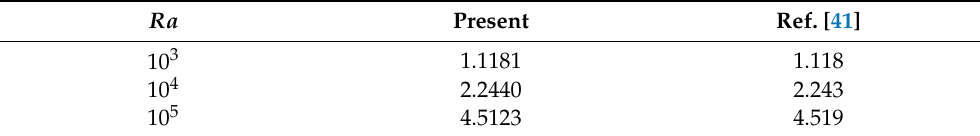
Table 2. Comparison of average Nu numbers in a NC flow problem in a square cavity. Ra Present Ref. [41] 10 3